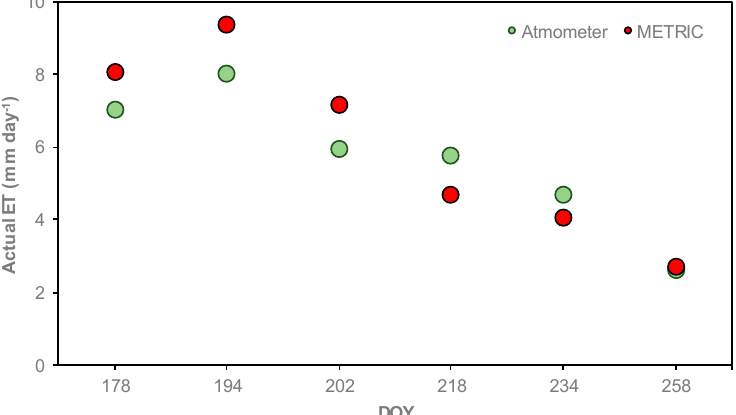
Figure 14. Progression and comparison between daily ETa estimated by the METRIC model (average values of each overpass date) and estimated by atmometer and crop coefficients (Kc) during the 2016 corn growing season.